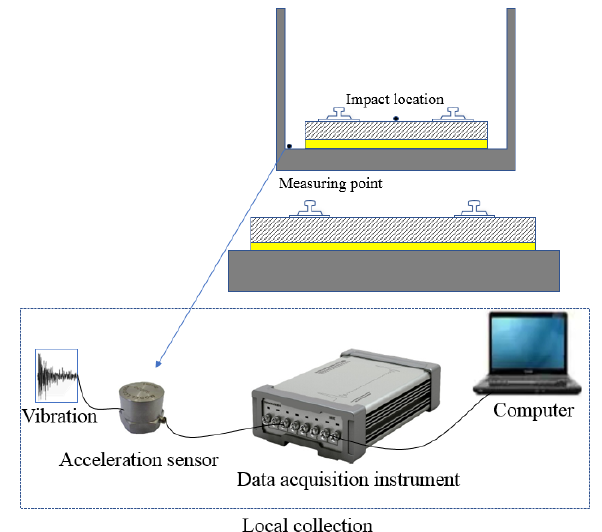
Figure 3. Sketch of laboratory test.